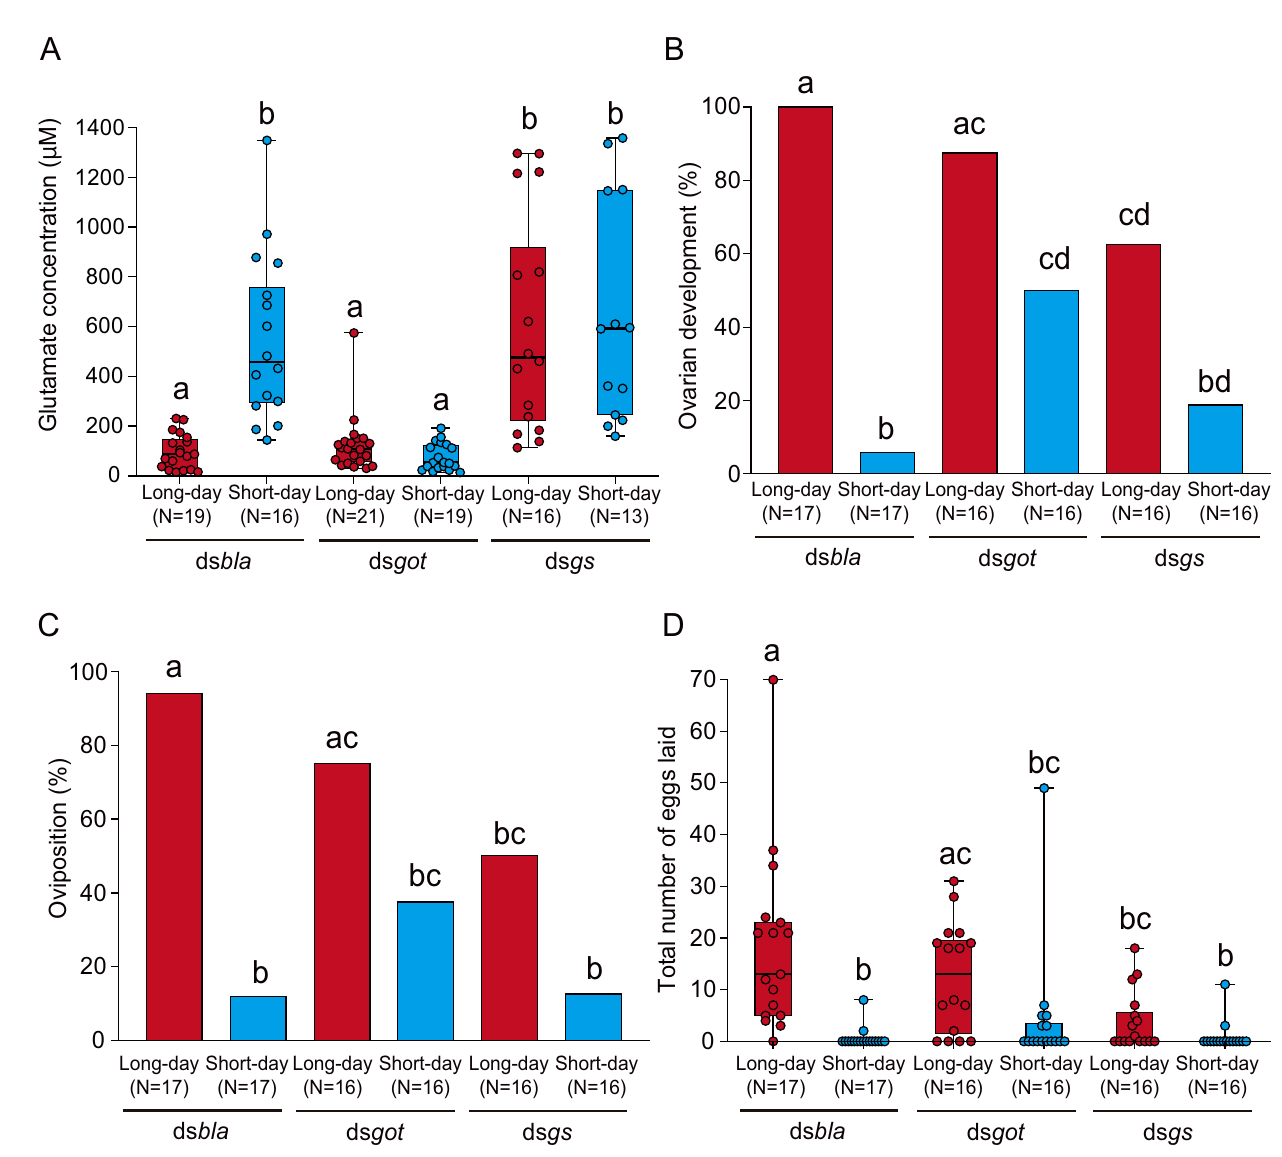
Fig 2. RNAi of got and gs affects extracellular glutamate levels and attenuates photoperiodic responses in reproduction. (A) Box and scatter plots showing the glutamate concentration in ds bla- , ds got -, and ds gs -injected females under long-day and short-day conditions. (B, C) Columns showing proportions of (B) ovarian development and (C) oviposition in ds bla- , ds got -, and ds gs -injected females under long-day and short-day conditions. (D) Box and scatter plots showing the total number of eggs laid in each group. (A–D) Columns and box plots with different letters indicate statistically significant differences (A, D: Steel–Dwass test; B, C: Tukey-type multiple comparisons for proportions, P < 0.05). (A, D) Lines at the top, middle, and bottom of the box plots indicate the upper quartile, median, and lower quartile, respectively. Upper and lower whiskers of the box plots indicate the maximum and minimum values, respectively. The underlying data can be found in the S1 Data datasheet of numerical values for each fig.xlsx. got , glutamate oxaloacetate transaminase ; gs , glutamine synthetase ; RNAi, RNA